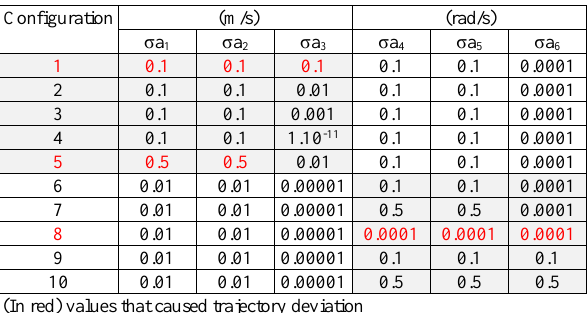
Table 1. Variation in the standard deviations of the polynomial parameters related to speed in the XYZ used as weighted constraints in the